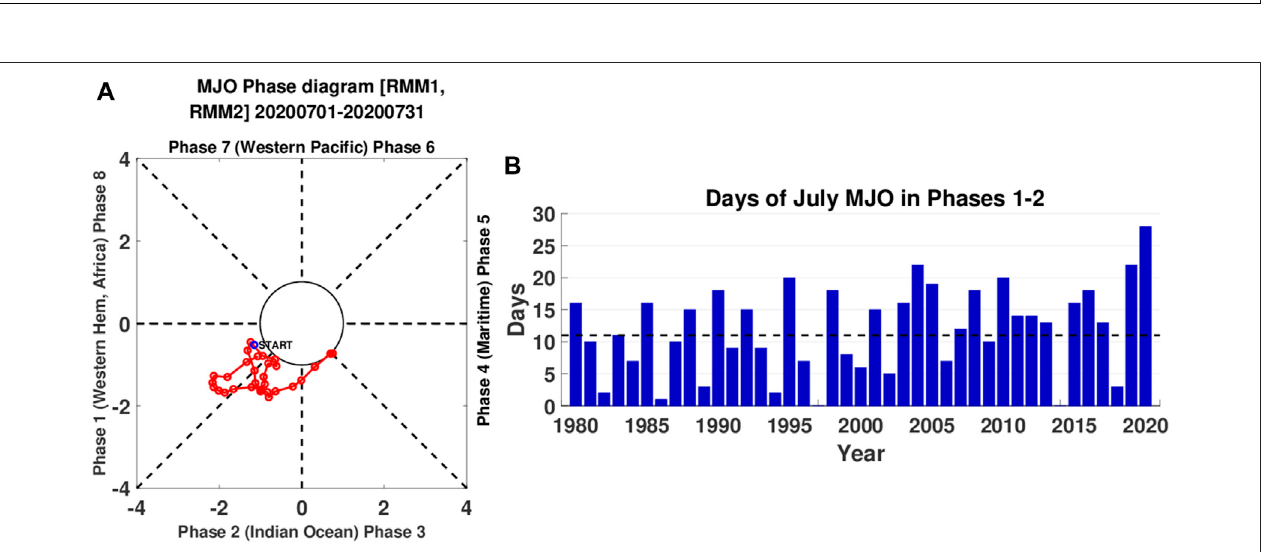
Frontiers in Earth Science |